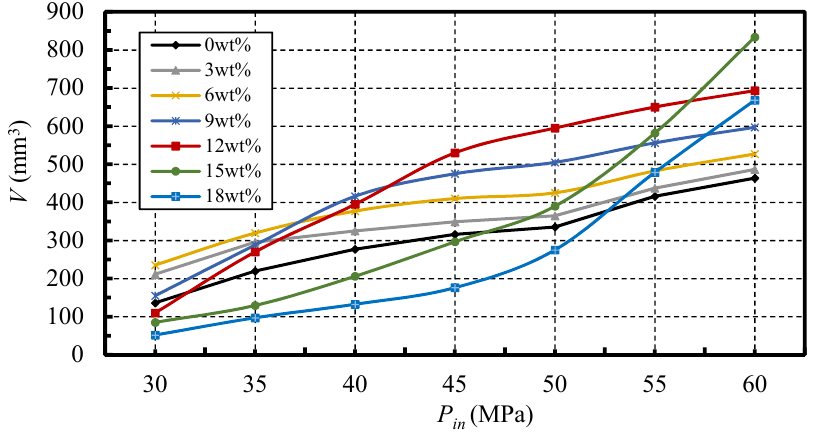
Figure 7. Rock erosion characteristics under various nozzle inlet pressures.